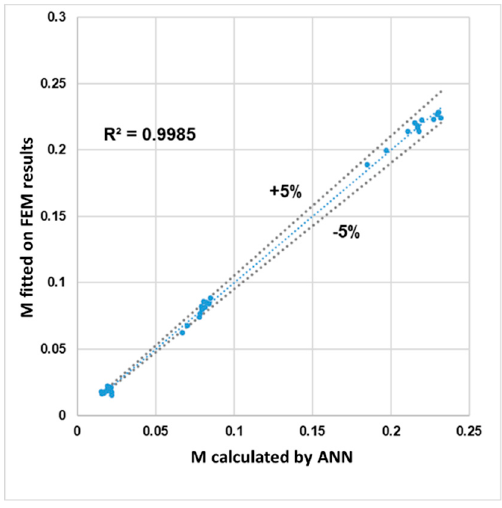
Figure 8. Plot of M from the analytical model M (target) versus the ANN trained M in blue with error bands at + 5% and − 5% in grey.